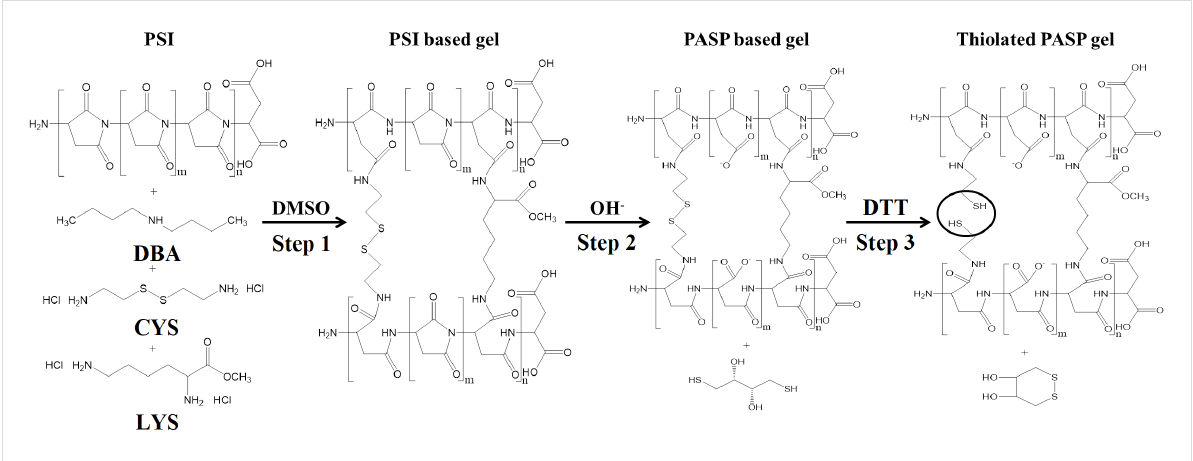
Figure 1: Synthesis of the simultaneously cross-linked and thiolated PSI and PASP gels.